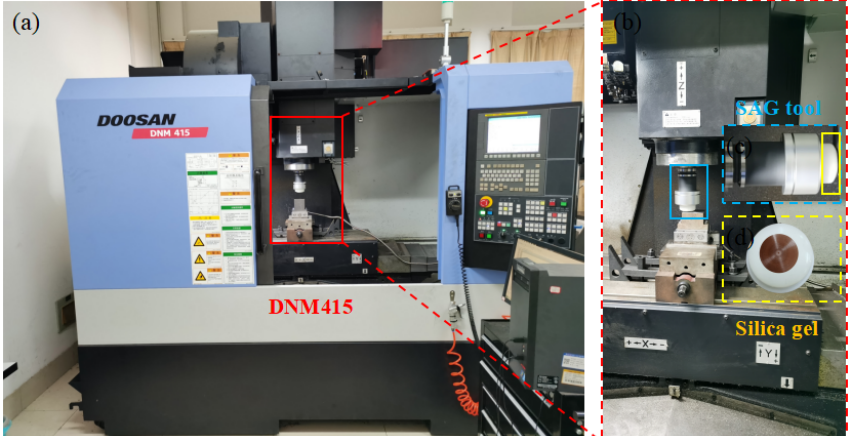
Figure 2. SAG experimental setup: ( a ) DNM415 CNC Machining Center, ( b ) SAG tool composition.